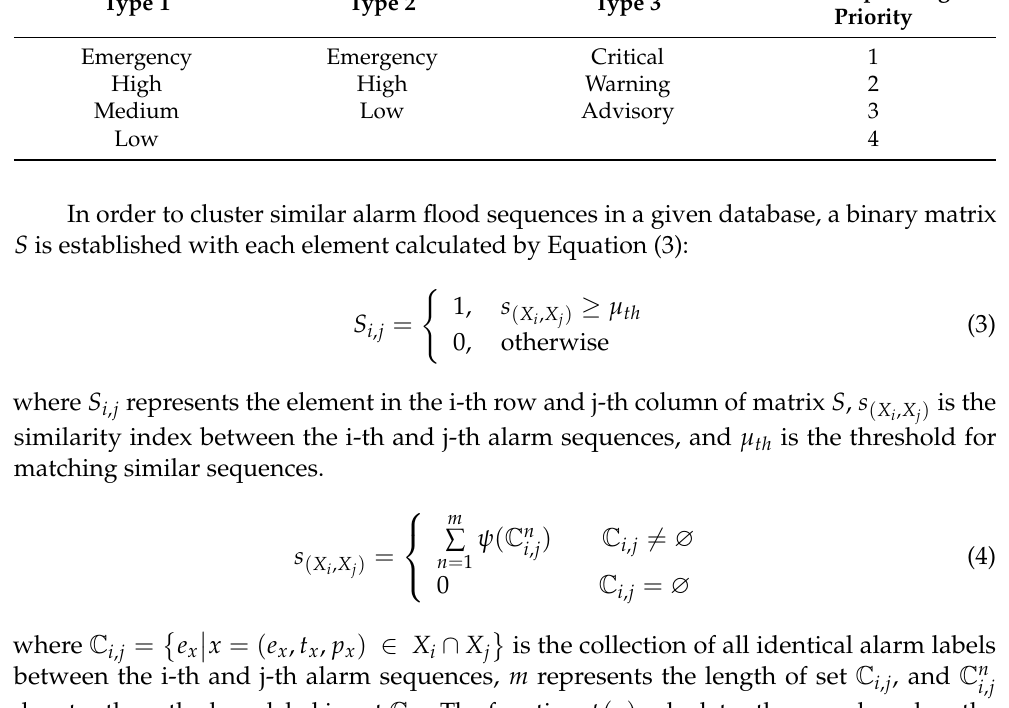
Corresponding Priority